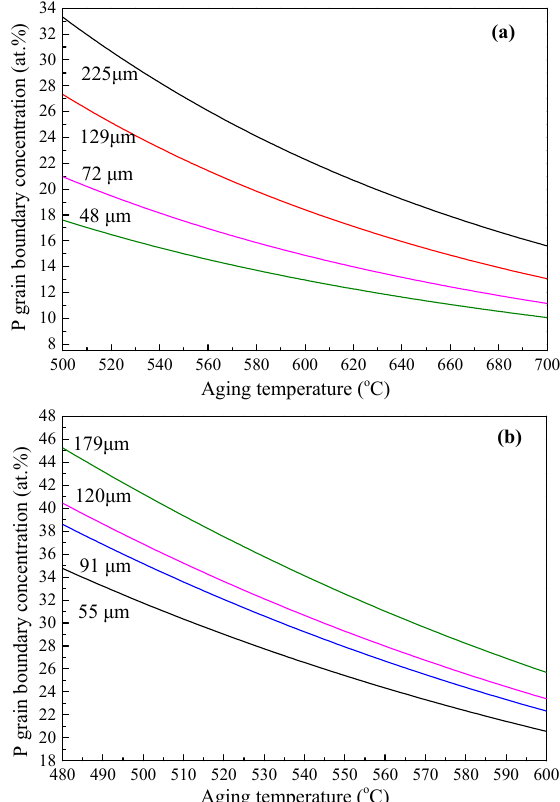
Figure 9. Predictions of equilibrium grain boundary segregation concentrations under different grain sizes: ( a ) IF steel; and ( b ) 2.25Cr-1Mo steel.